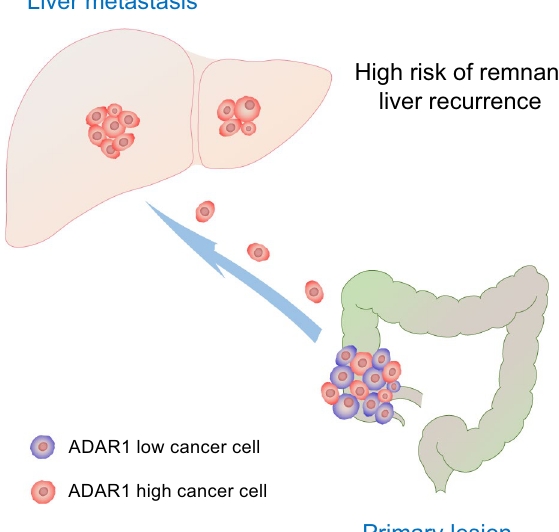
Figure 5. Highly malignant colorectal cancer cells with a high ADAR1 expression cause liver metastases. High- malignant cancer cells with a high ADAR1 expression are more likely to cause liver metastases, and even a small number of cells can easily metastasize, thereby resulting in remnant liver recurrence over